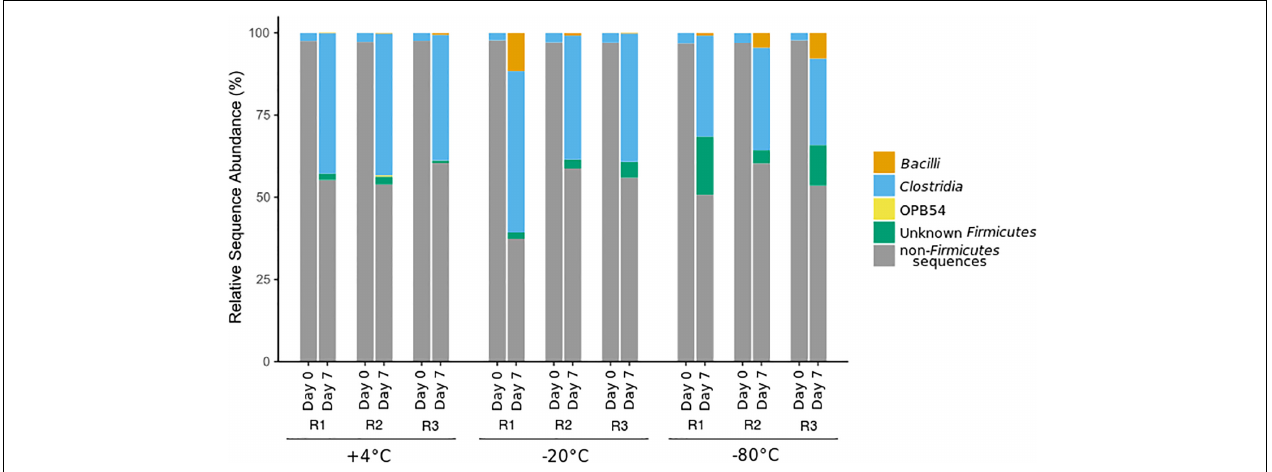
FIGURE 2 | Class-level community structure within the phylum Firmicutes based on 16S rRNA gene amplicon sequencing before (day 0) and after (day 7) incubation at +50 ◦ C. Sequences affiliated with other phyla (not Firmicutes ) are represented in gray. Replicates are identified as R1, R2, and